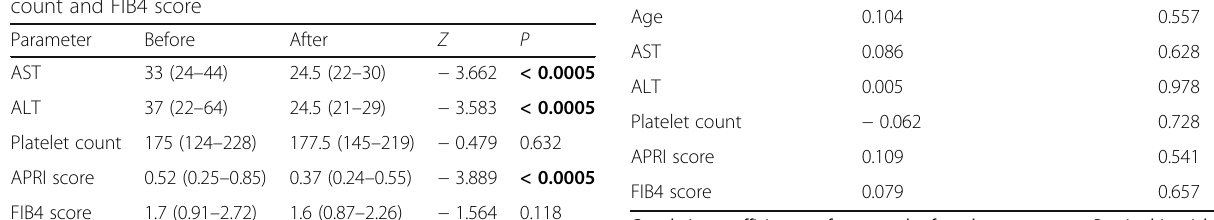
Correlation coefficient: r pb for sex and r s for other parameters. P point bi-serial for sex and Spearman ’ s correlation for other